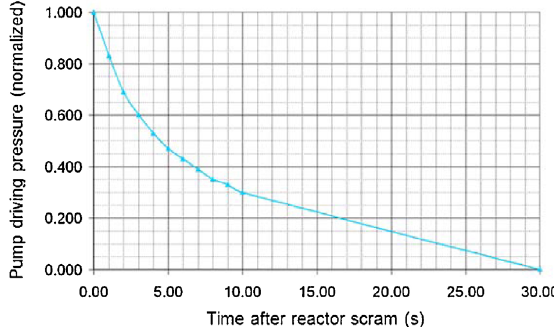
Fig. 8. Coolant pumps driving pressure after reactor scram.